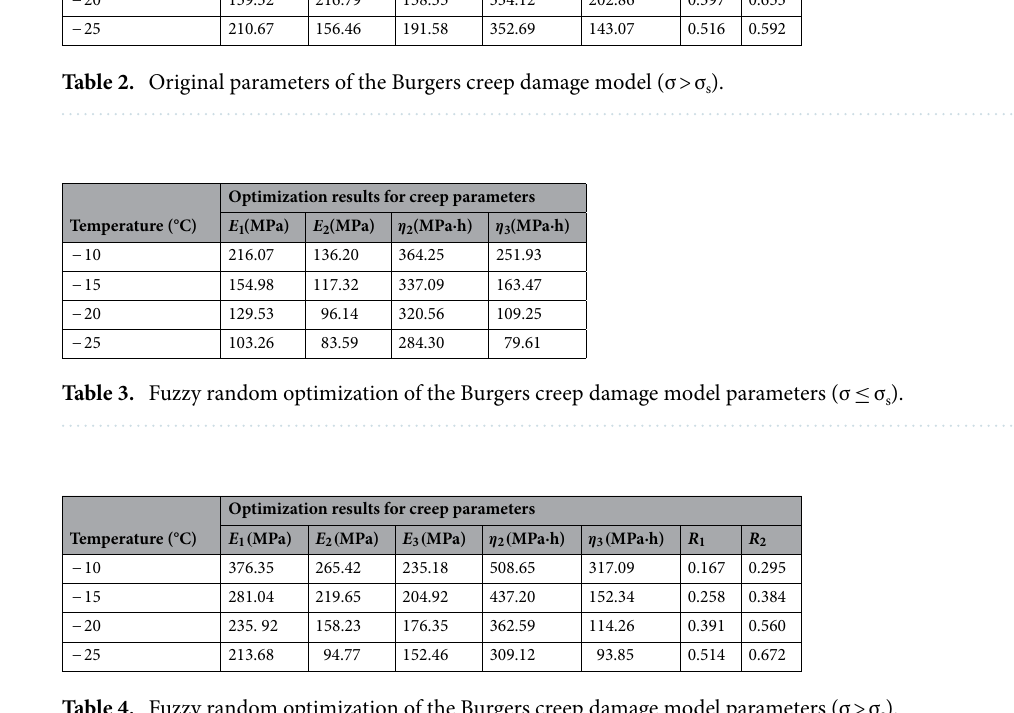
Table 4. Fuzzy random optimization of the Burgers creep damage model parameters (σ > σ s ).